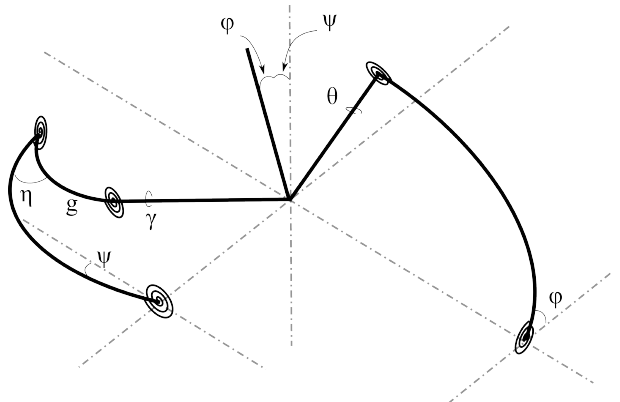
Figure 4. Angle nomenclature used to develop Eq.